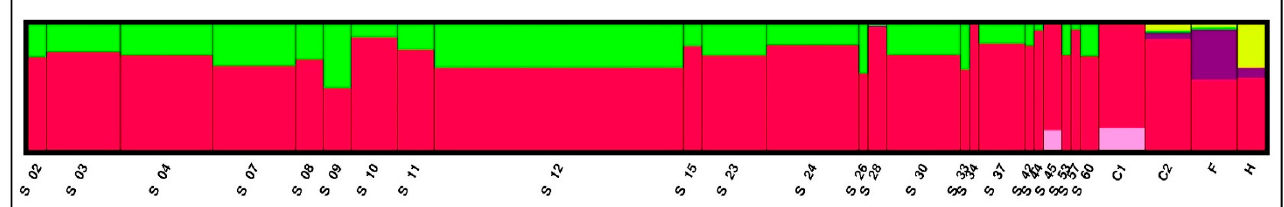
Figure 1. The bar plot of structure results for the most probable division into K = 5 genetic groups. The included populations of isolates from strawberry plants in the Czech Republic are labelled “S” and by ID of sampled locality; C1, C2, F and H refer to the groups identified earlier.